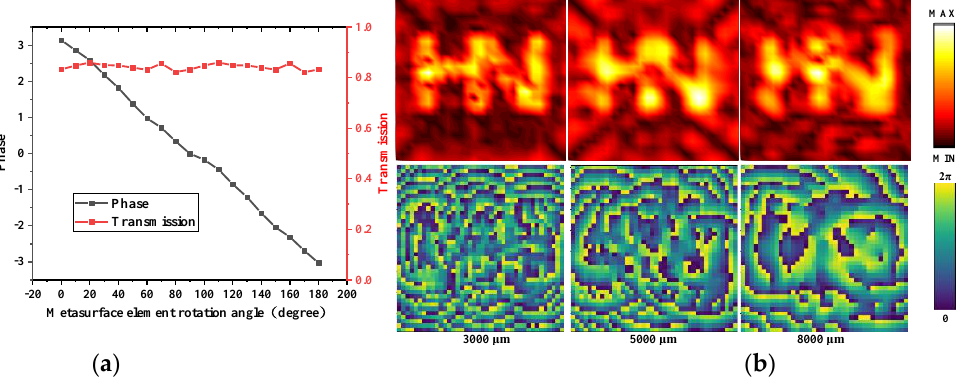
Figure 8. ( a ) The relationship between the rotation angle of the metasurface and phase. ( b ) The phase distribution on the metasurface hologram and holographic plate at 3000 μm, 5000 μm and 8000 μm imaging distances.